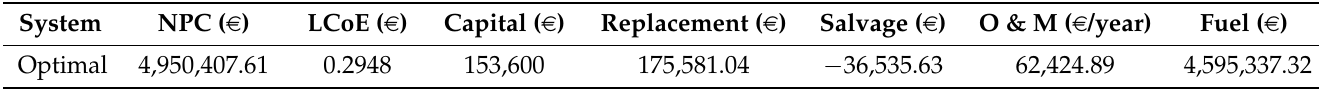
Figure 10. Wind Turbine Power output. Table 12. Economic characteristics of the optimal configuration of Scenario 1.